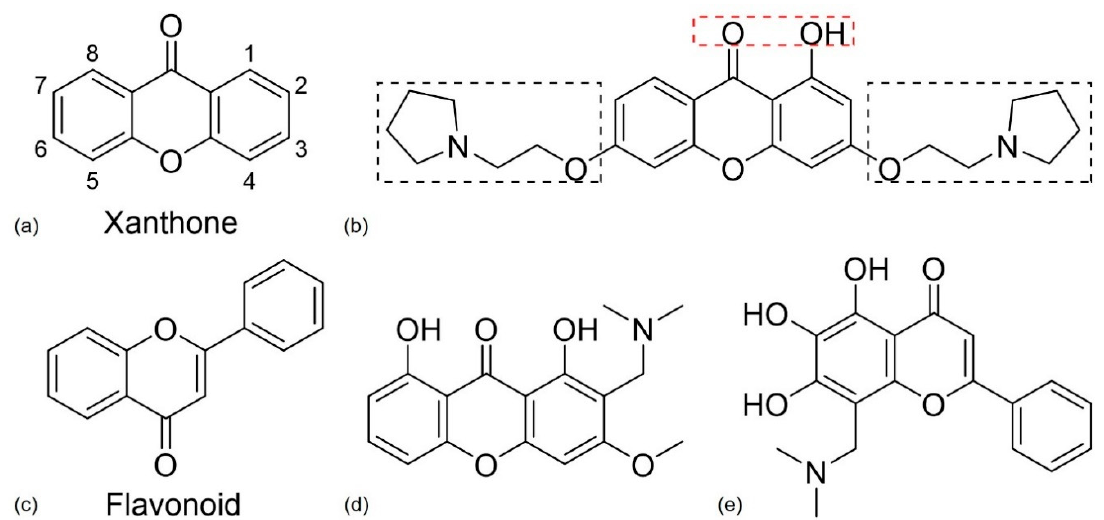
Figure 11. ( a , c ) Chemical structure of xanthone and flavonoid nucleus, respectively. ( b ) Chemical structure of the most promising xanthone derivative according to Kou et al. [111]. The substituents in the red rectangle can work as a metal chelating agent and and antioxidant, while the substituents in the black rectangle lead to antioxidant and anti-acetylcholinesterase (AChE) activity. Adapted from [111]. ( d , e ) Chemical structures of the most promising xanthone and flavone derivatives, respectively, obtained by Cruz et al. [101] for AD.